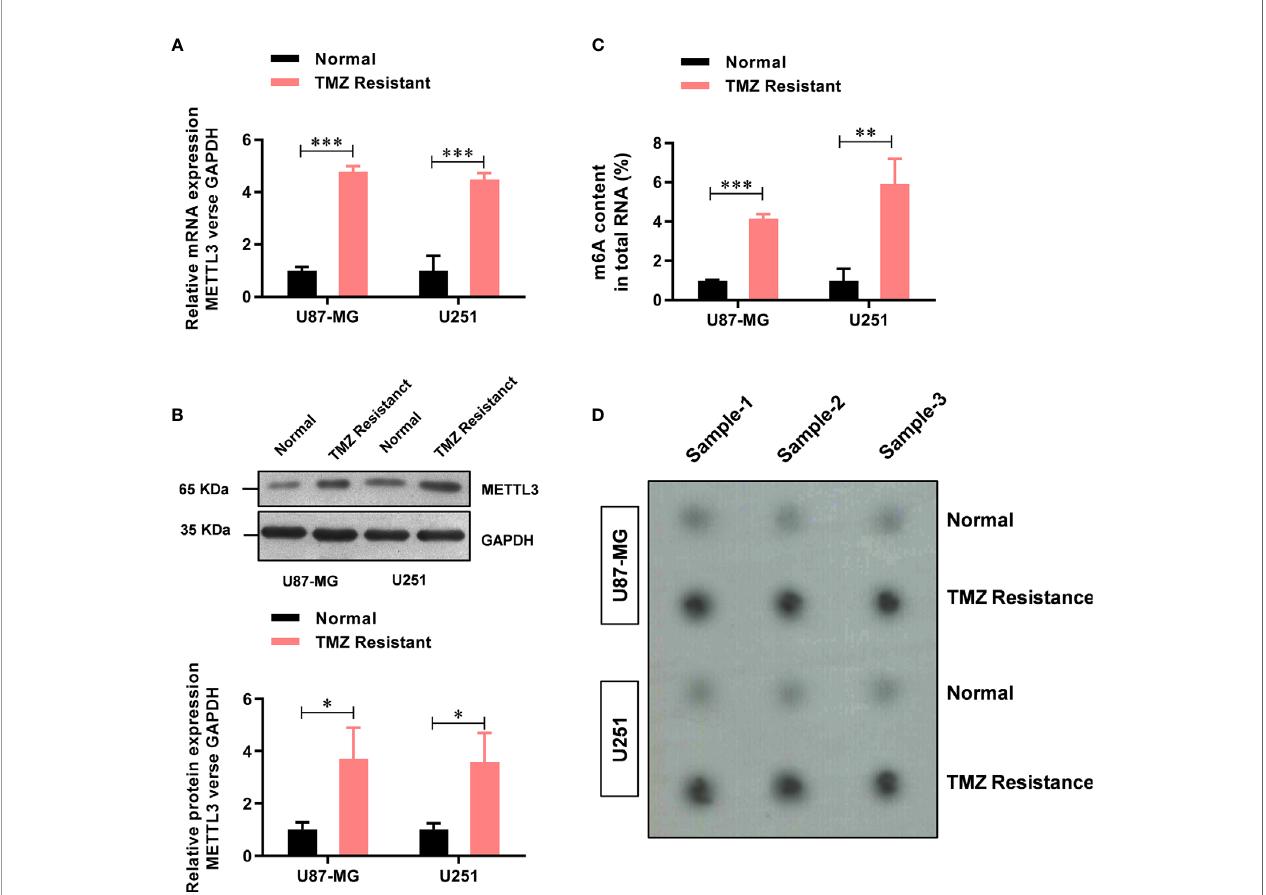
FIGURE 1 | METTL3-mediated m 6 A is elevated in the TMZ-resistant GBM cells. (A) The mRNA level of METTL3 in TMZ sensitive and resistant U87-MG/U251 cells was analyzed by real-time PCR. (B) The protein level of METTL3 in TMZ sensitive and resistant U87-MG/U251 cells was analyzed by western blot. (C) The colorimetric m 6 A quanti fi cation assay was used to examine the total m 6 A levels in the TMZ sensitive cells and the resistant U87-MG/U251 cells. (D) The dot blot was used to con fi rm the total m 6 A levels in the TMZ sensitive cells and the resistant U87-MG/U251 cells. * P < 0.05, **P < 0.01, and ***P< 0.001 versus normal U87-MG/U251